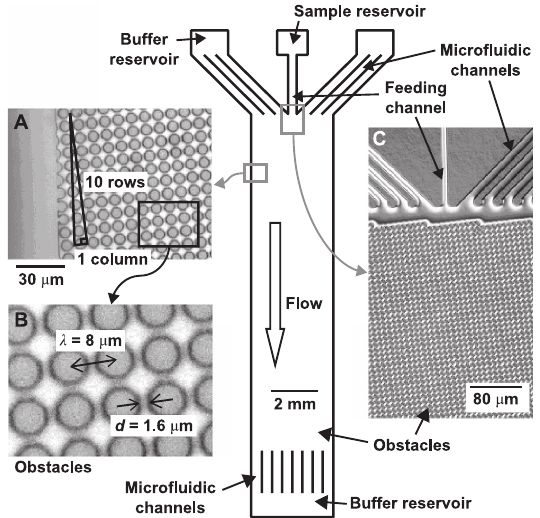
Fig. 4 Schematic of a microfluidic device for continuous-flow separation. The microfluidic channels and the matrix were fabricated on a silicon wafer using conventional photolithography and deep reactive ion etching tech- niques (Huang L.R. et al.,